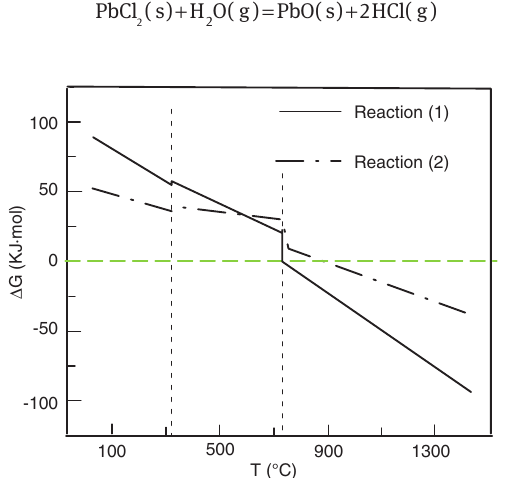
volatile reaction and 2